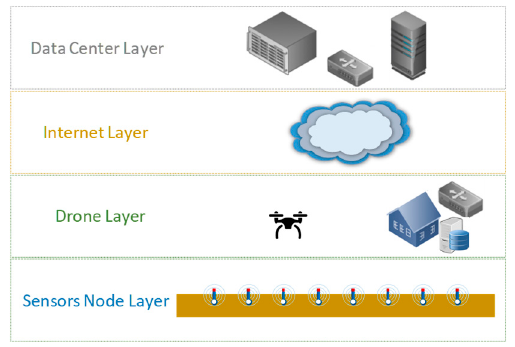
Figure 4. Architecture layers.